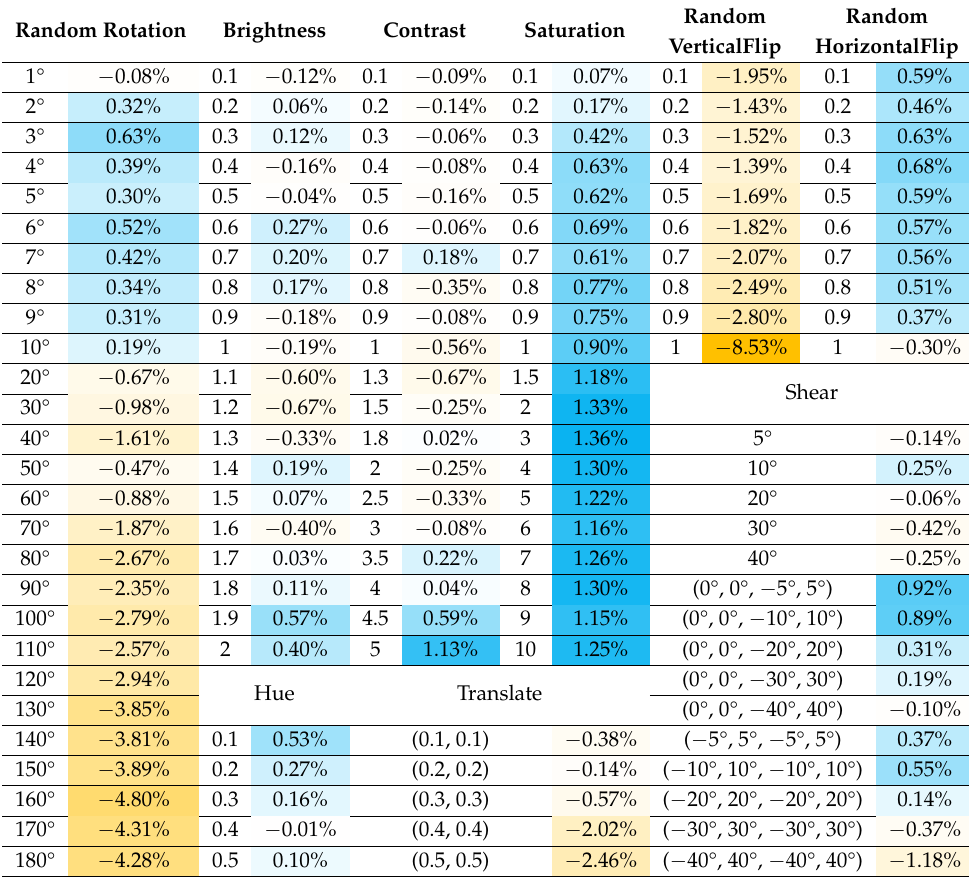
Table 8. Performance of DA methods on Γ train 50 on Γ train 50 classification performance, which is very different from the impact on Γ train CSD is displayed. The displayed percentage values describe the increase/decrease of mAA in percent. The value is color-coded from blue (increase in accuracy) over white (no effect) to orange (decrease in